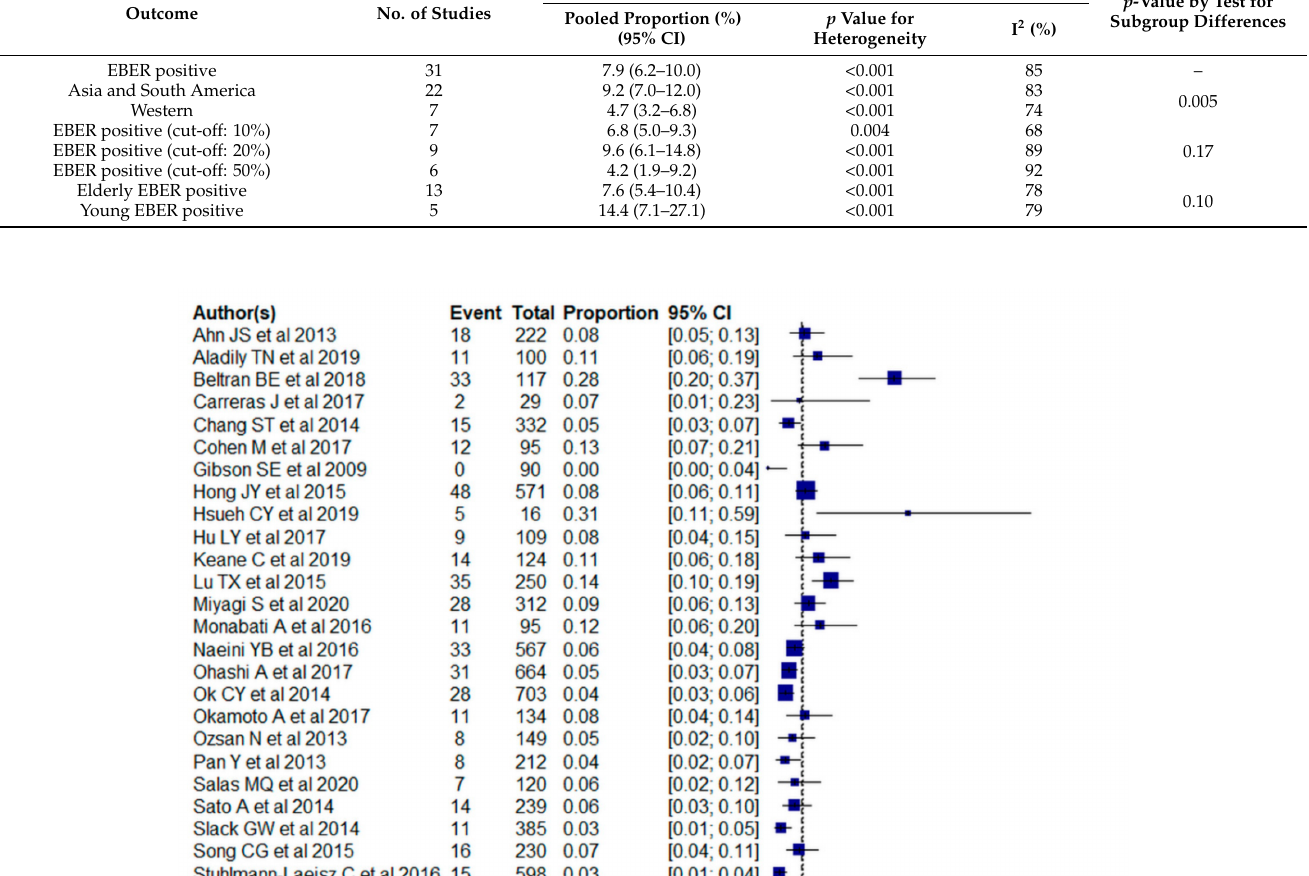
Table 3. Summary of the meta-analytic pooled proportion for various outcomes among the included studies. Outcome